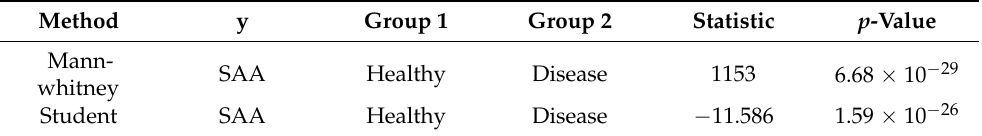
Table 2. The t -test comparison of the serum amyloid A concentrations between the healthy and diseased cow groups.